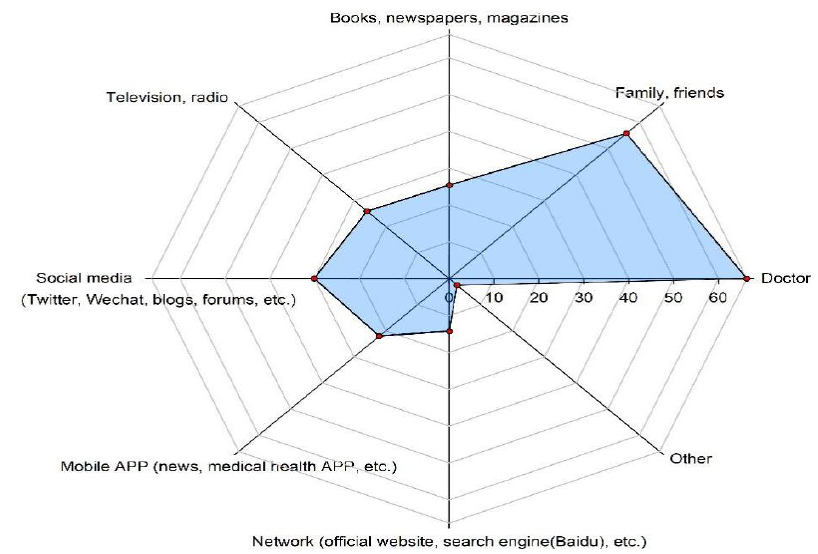
Figure 2. Primary sources of information on non-EPI vaccinations (N = 7318).